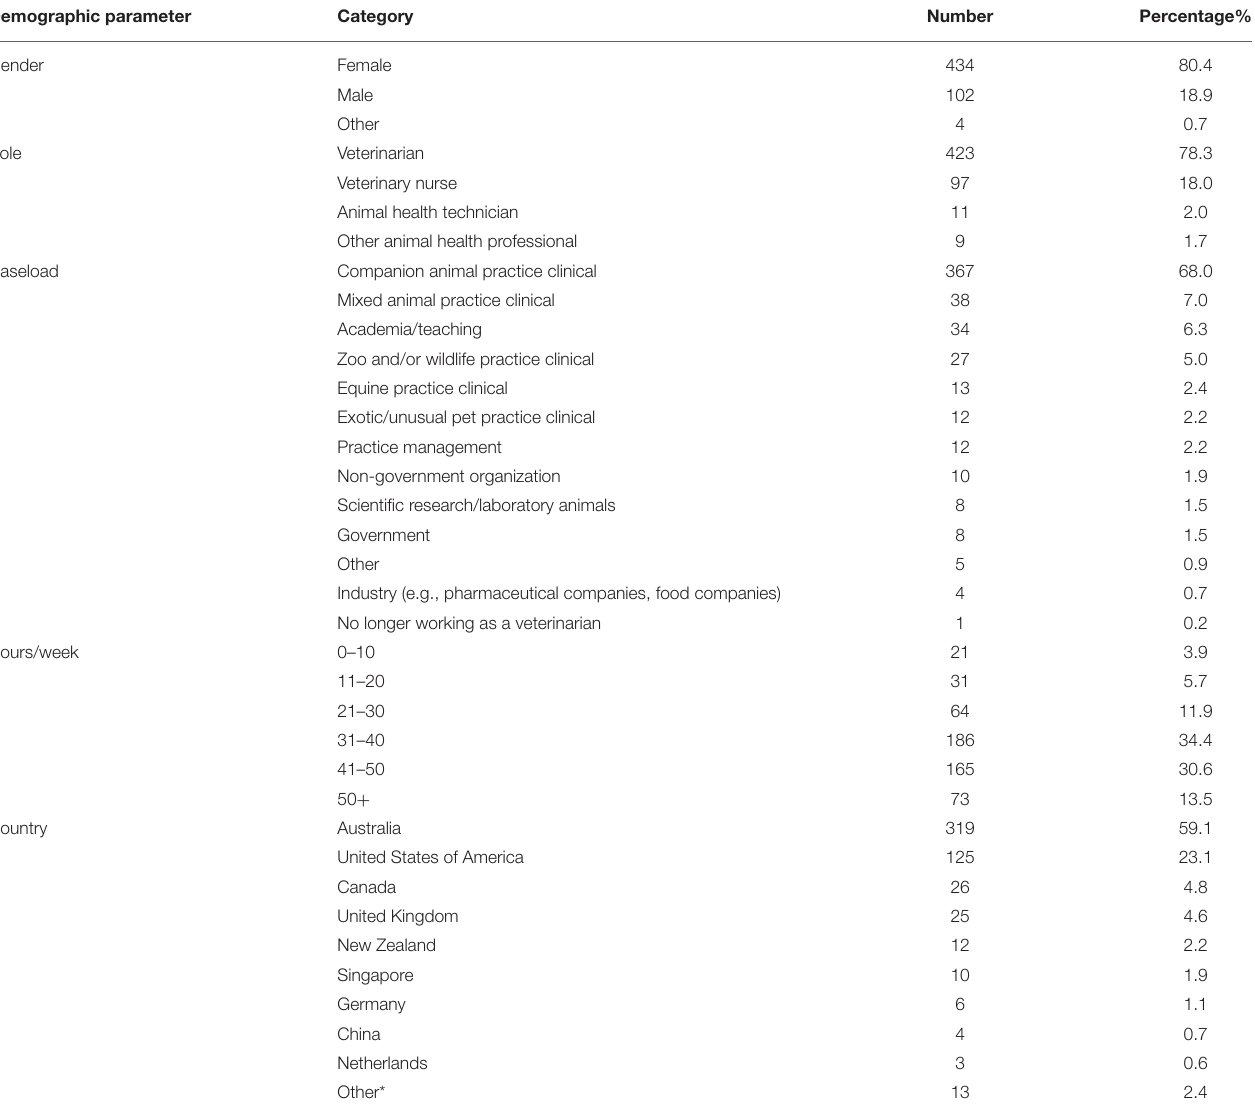
TABLE 1 | Frequency table for the demographic information on respondents to mixed methods survey on ethically challenging situations encountered by veterinarians, animal health technicians and veterinary nurses globally in the COVID-19 era in 2020 ( n = 540). Demographic